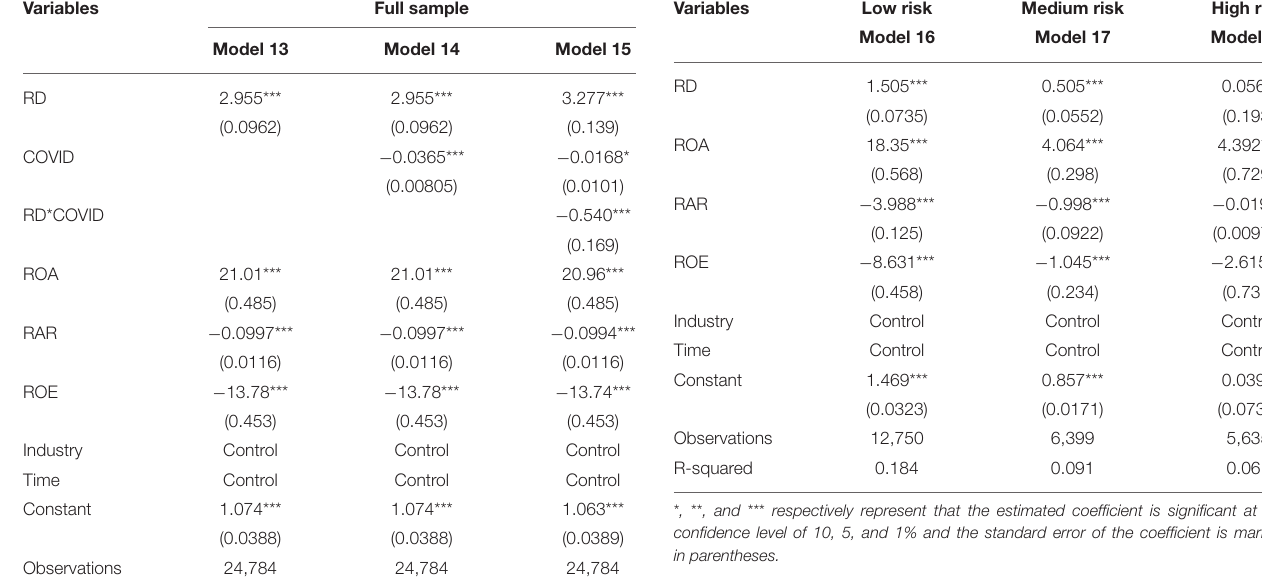
TABLE 4 | Whether the outbreak of the COVID-19 affects the impact of R&D investment on the financial risk of enterprises. Variables